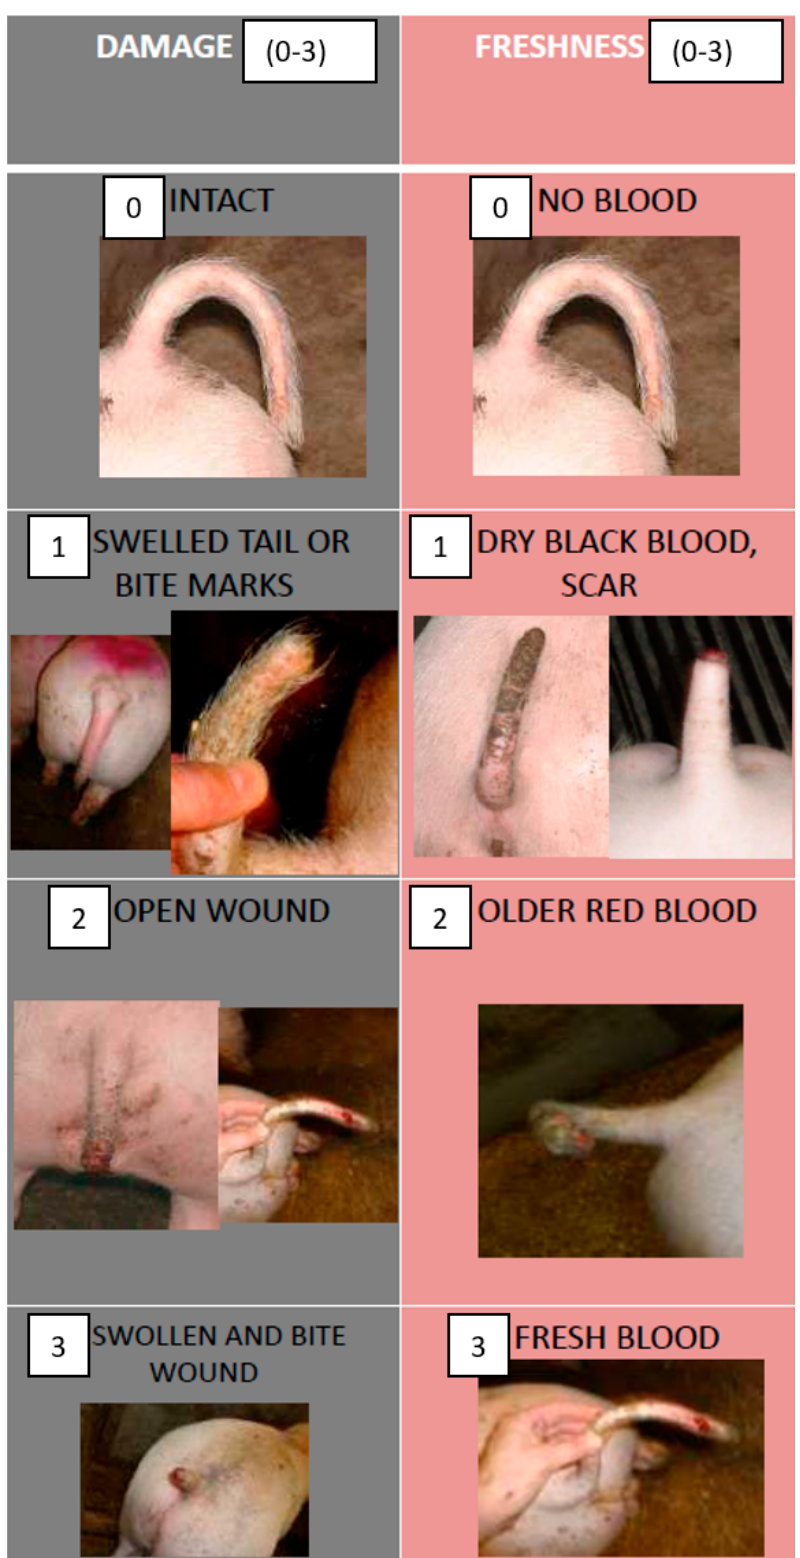
Figure A1. Tail Lesion Scoring System Developed by the FareWellDock Consortium .